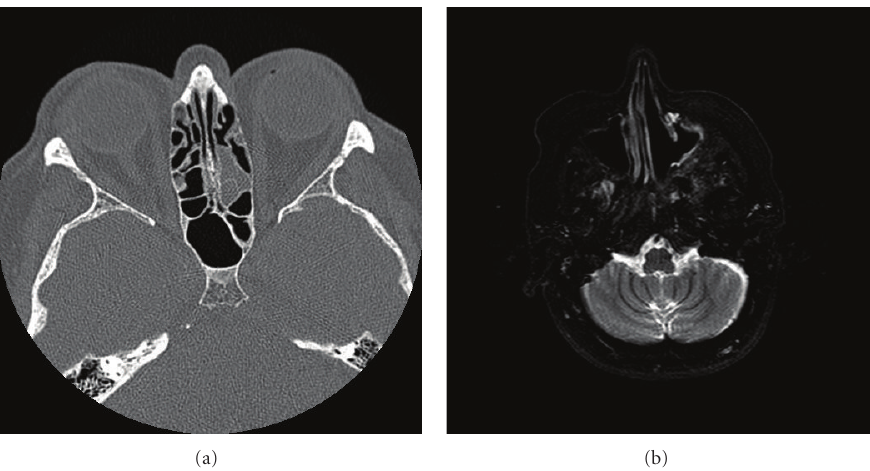
Figure 3: (a) CT scan taken in 2007 showing soft tissue with bony wall destruction in the patient’s left posterior ethmoid sinus, which was a recurrence of the malignancy and treated with topical chemotherapy. (b) MRI scan taken in 2008 showing an area of high signal in the patient’s left maxillary antrum, indicating the need for a biopsy to be performed.